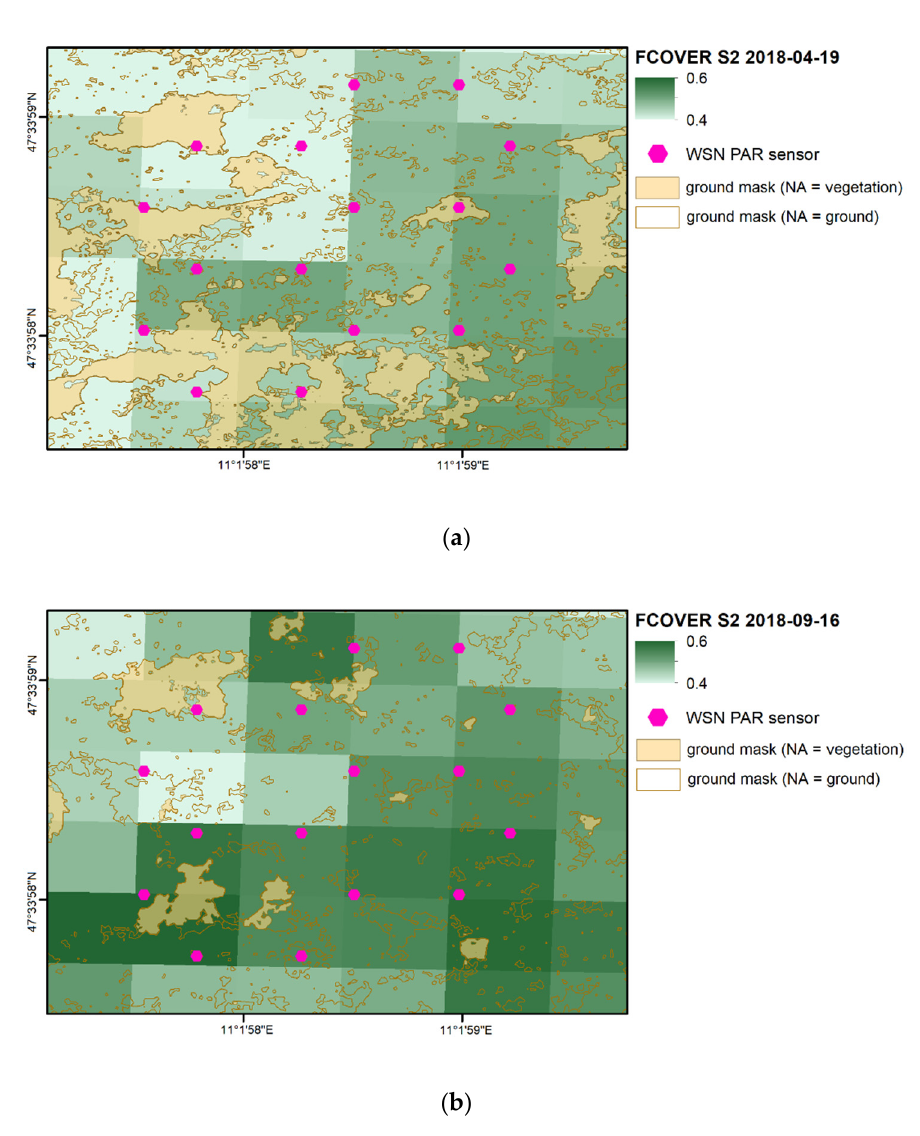
Figure 8. FCOVER-S2 and UAV-derived ground masks at ( a ) the spring and ( b ) summer acquisition dates.